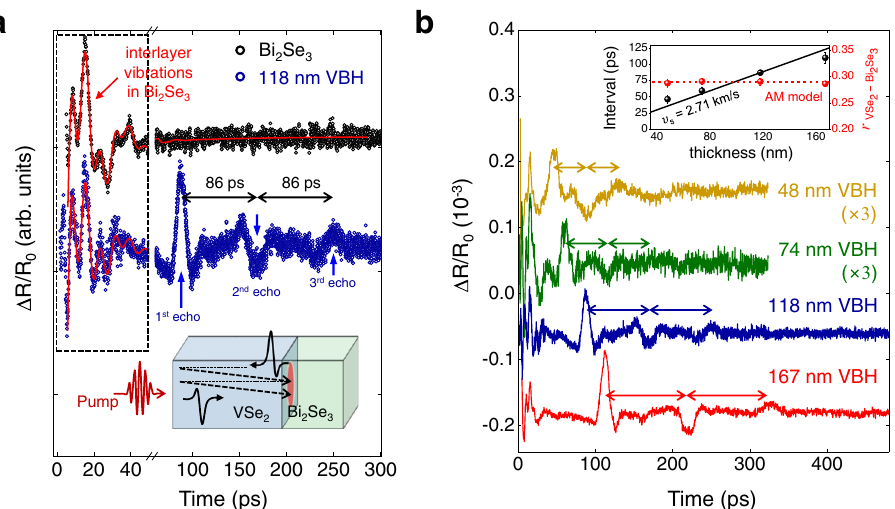
Fig. 2 Thickness-dependent coherent acoustic phonon (CAP) dynamics of VSe2/Bi2Se3 heterostructures (VBHs). a Pump – probe signals of VSe 2 - thickness-dependent background-free CAPs of VBHs with ~0.93 to 0.95 eV probe energy, where Δ R/R 0 represents the transient re fl ectance. The dashed box indicates the CAP signals from 10 quintuple layer (QL) Bi 2 Se 3 . The upward/downward arrows indicate acoustic pulse echoes at the VSe 2 /Bi 2 Se 3 interfaces. Simpli fi ed schematic of pump – probe experiments and Dynamic illustration of acoustic waves in VSe 2 generated by optical pump pulses and reciprocated by re fl ection at the air and Bi 2 Se 3 interfaces (Inset). The red curves indicate fi tting results with damped oscillation of interlayer vibrations in Bi 2 Se 3 . The time intervals between echoes (~86 ps) are listed. b VSe 2 -thickness dependent interfacial CAP dynamics of VBHs. Obtained echo interval (black dots) versus VSe 2 thickness and amplitude re fl ection coef fi cient (red dots) (Inset). The line fi t (black line) to the interval data provides the sound speed of VSe 2 (2.71 km s − 1 ). Inset: The dash red line indicates the predicted re fl ection coef fi cient based on the acoustic mismatch model for the atomically fl at